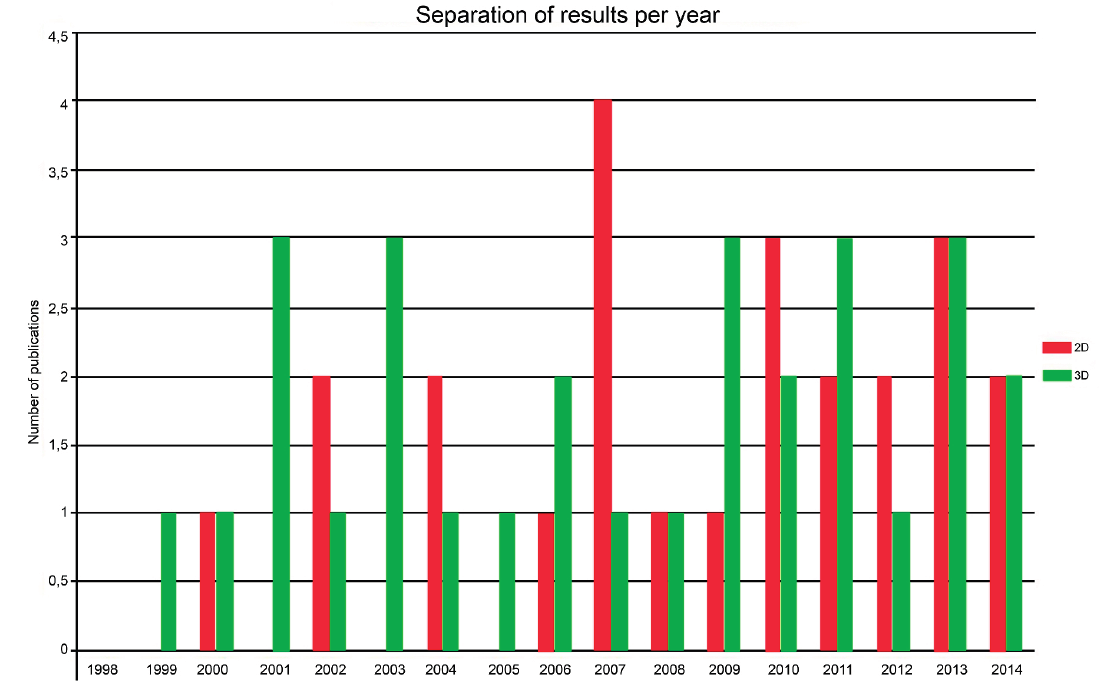
Figure 5. Separation of the amount of type of result (2D/3D) per year (ISI-indexed